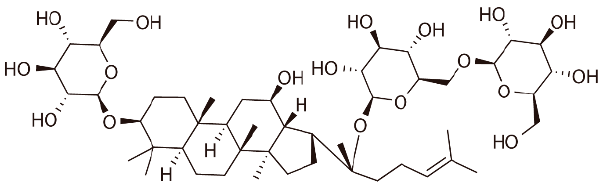
Figure 1. The chemical structure of GP-17.